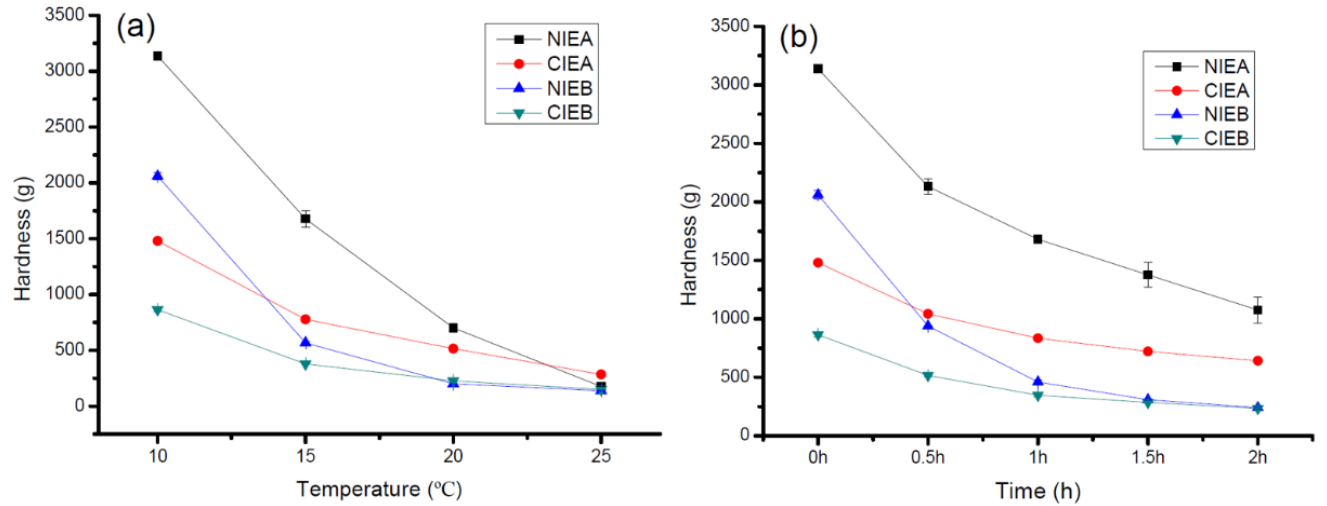
Figure 6. The hardness of samples at different temperatures ( a ) and the hardness changes vs. time ( b ) when refrigerated samples were placed at 20 ◦